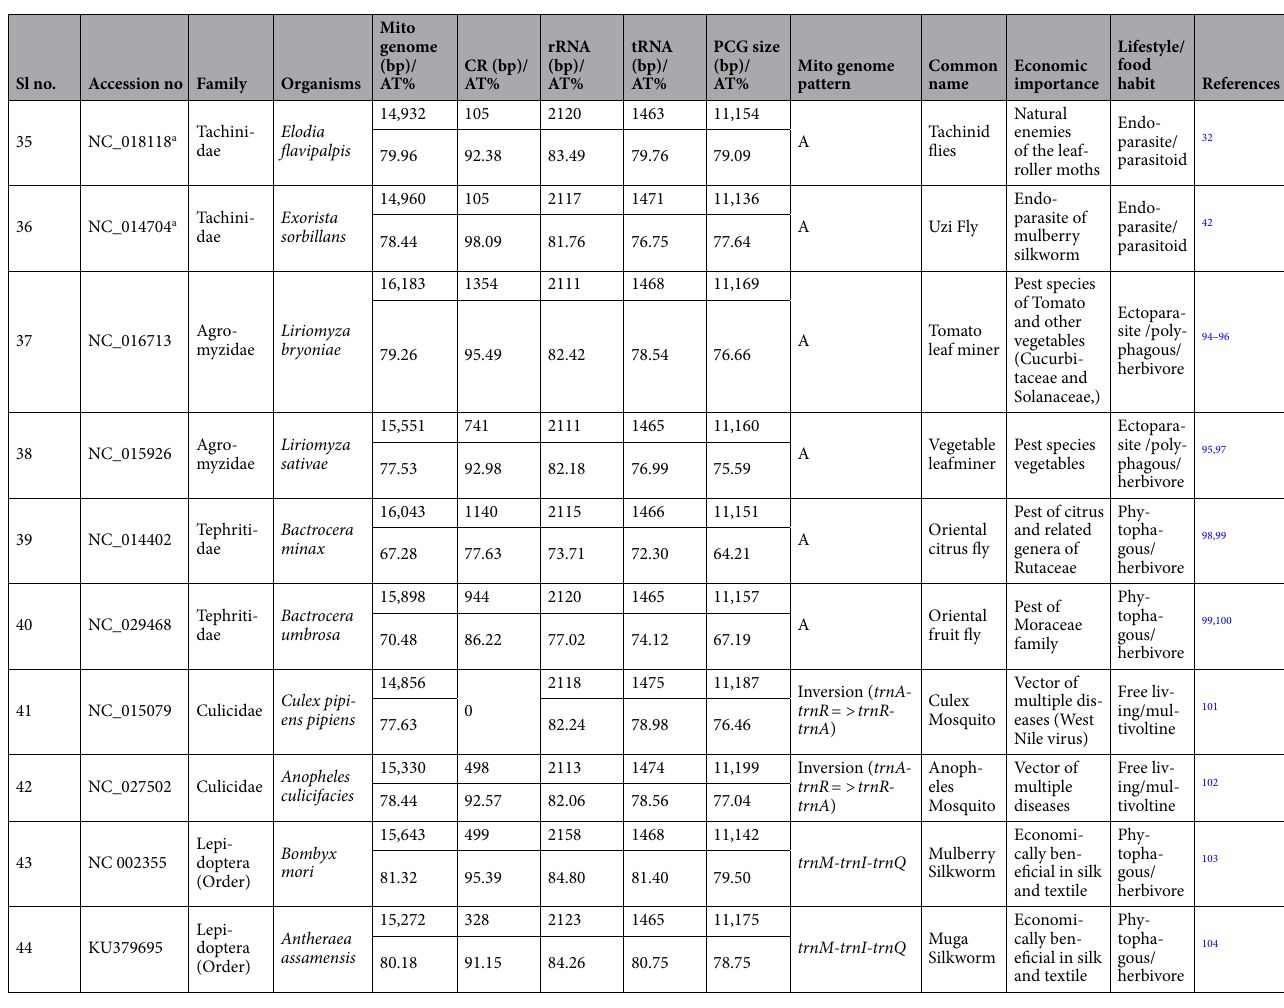
Table 1. List of Diptera (n = 42) and Out group Lepidoptera (n = 2) used in this study for comparative mitogenomics and phylogenetic analysis (A = Ancestral mitogenome arrangement). a Mitogenomes were used for manual curation of Blepharipa